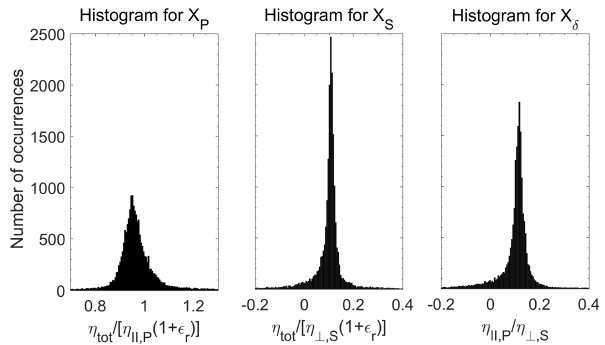
Figure 6. Histograms for the interchannel constants X P , X S , and X δ . Each point corresponds to a combination of z j and z k in a 5min period, obtaining about 18000 data points for this 3h measurement case. Table 1. Values of the instrumental interchannel constants and cross-talk factor determined for the measurement case presented.